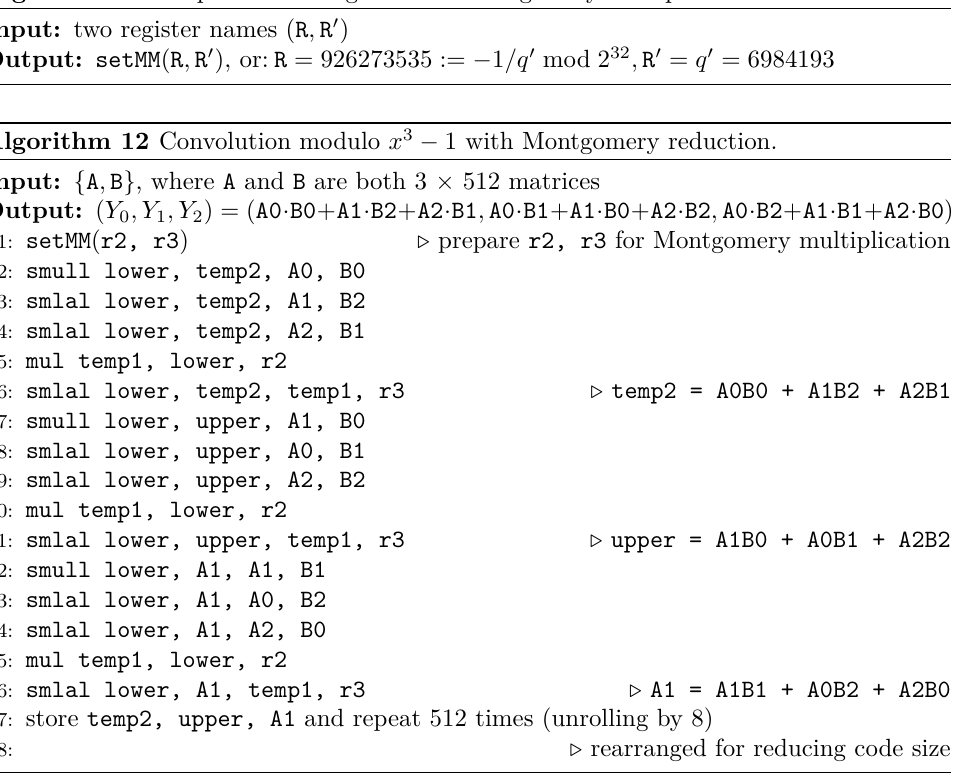
Algorithm 11 Preparation of registers for Montgomery multiplication.